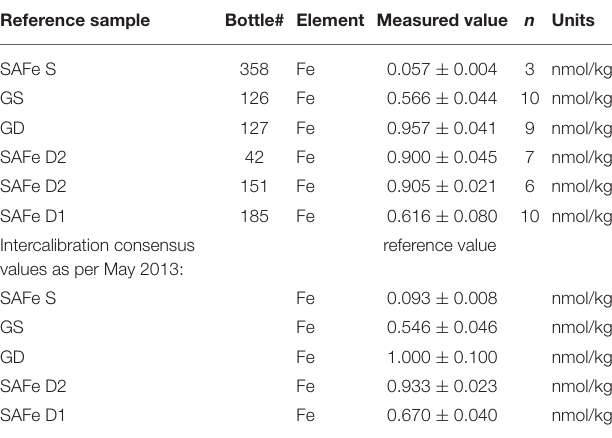
TABLE 2 | The values of SAFe and GEOTRACES reference samples for DFe measured on board using flow injection analysis based on luminol chemiluminescence during cruise PS94 in the Arctic Ocean.